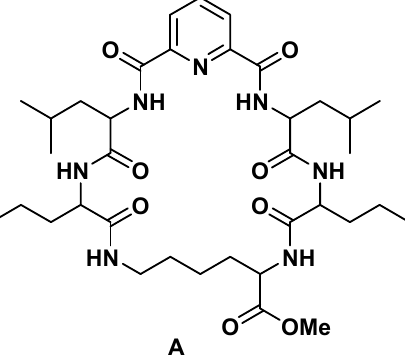
Figure 1. Structure of the anticancer agent.